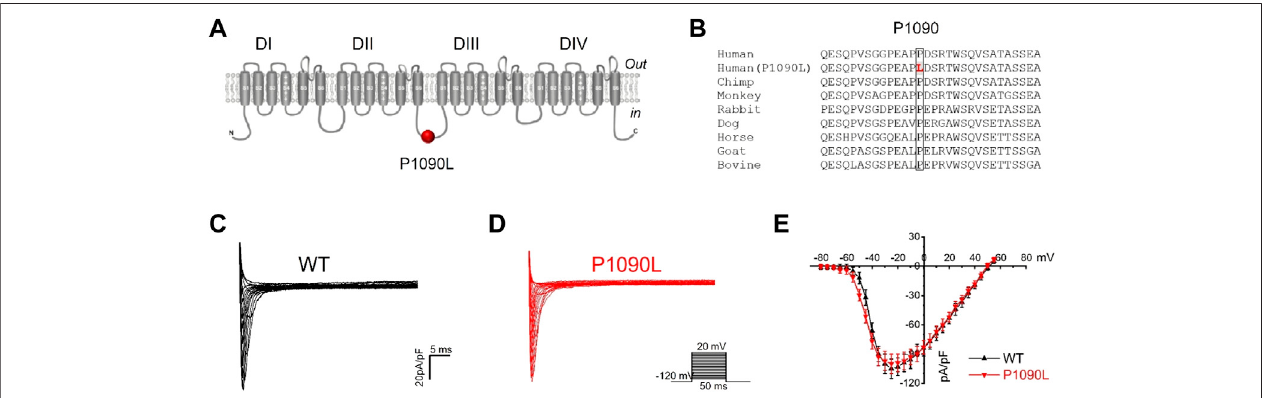
FIGURE1 | Asian-speci fi cmutation P1090Lin the Na v 1.5sodiumchannel. (A) . Topological diagram showingP1090Llocated inthe intracellular loop between the DII-DIII domain of the Na v 1.5 channel. (B) . Na v 1.5 sequence alignment indicates that the P1090 is highly conserved across vertebrate species. (C,D) : Representative wild-type(WT) (C) andP1090L (D) sodiumcurrents.Currentsweremeasured fromaholdingpotentialof − 120 mVtotestpotentialsrangingbetween − 110and+60 mV in 5 mV steps. (E) . Average peak current-voltage (I-V) relationships for WT channel and P1090L mutation ( n = 8 cells in each group, data are presented as the mean ± SEM).